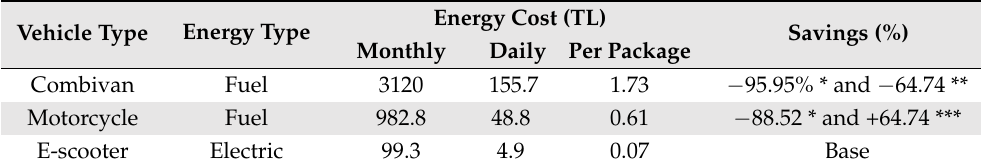
Table 6. The vehicle types in terms of energy dimension.